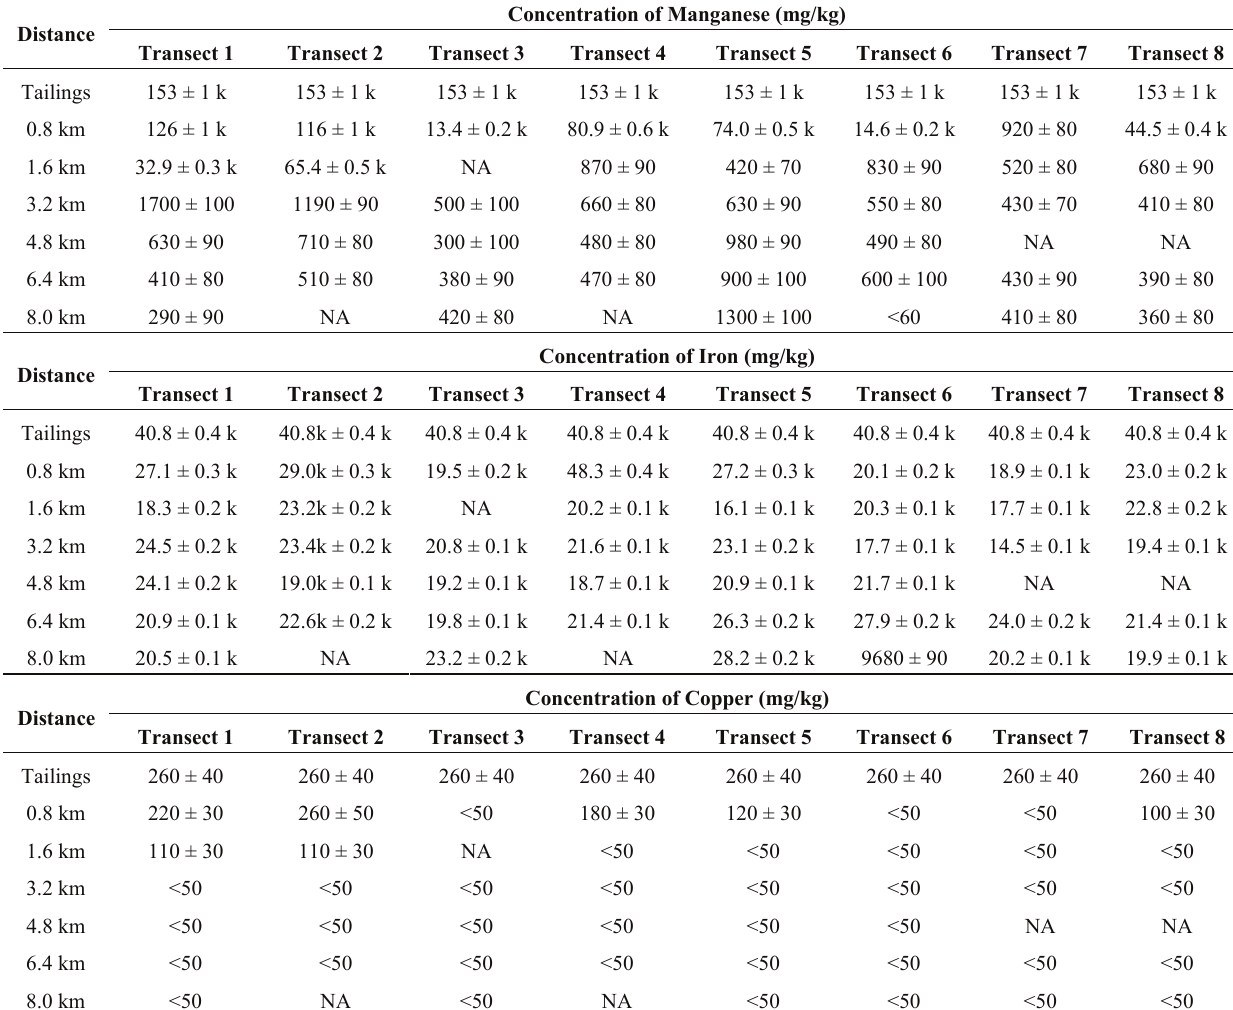
Table A1. XRF results for Thr ee Kids Mine Soil (1σ; 68% confidence interval)